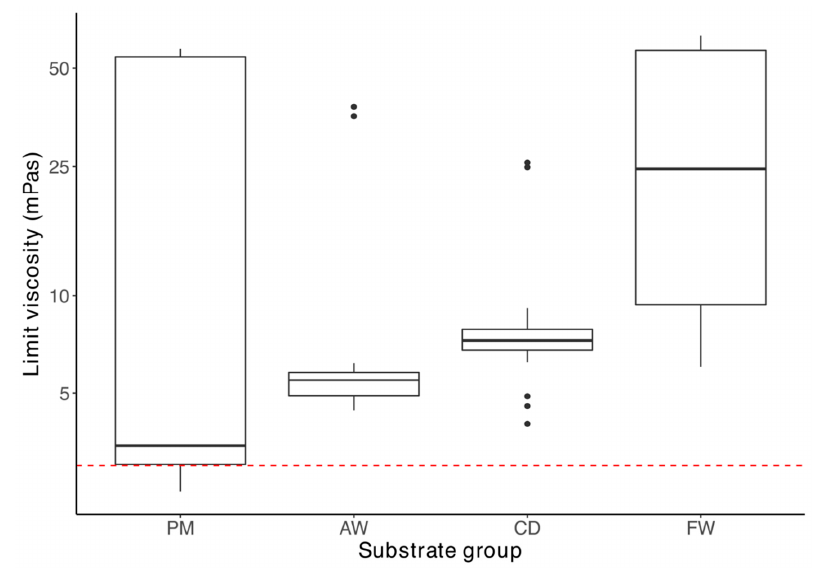
Figure 1. Limit viscosity (shear rate 800 s − 1 ) values for fluids of continuous stirred-tank biogas reactors (CSTBRs) digesting different substrate groups: PM, papermill waste; AW, agricultural waste; CD, co-digestion; and FW, food waste. The red dashed line approximates the lower limit of the measuring range of the rheometer measuring system.